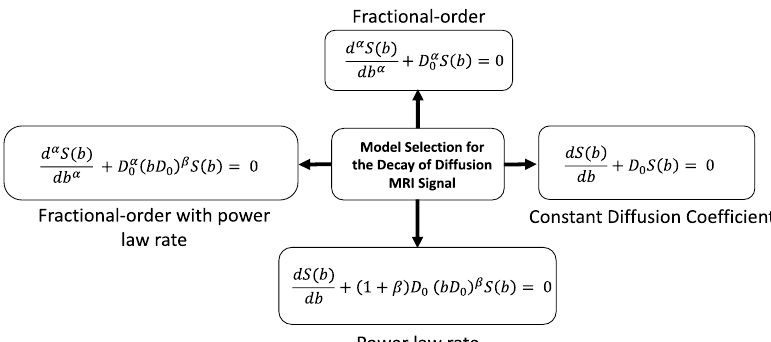
Figure 2. A diagram illustrating four approaches selected for generalization of the classical Gaussian model of diffusion-weighted signal attenuation in magnetic resonance imaging (MRI) (integer or fractional order, each with a constant diffusion coefficient or one with an inverse power law decay). An example of a representative differential equation for S(b) is shown for each case.